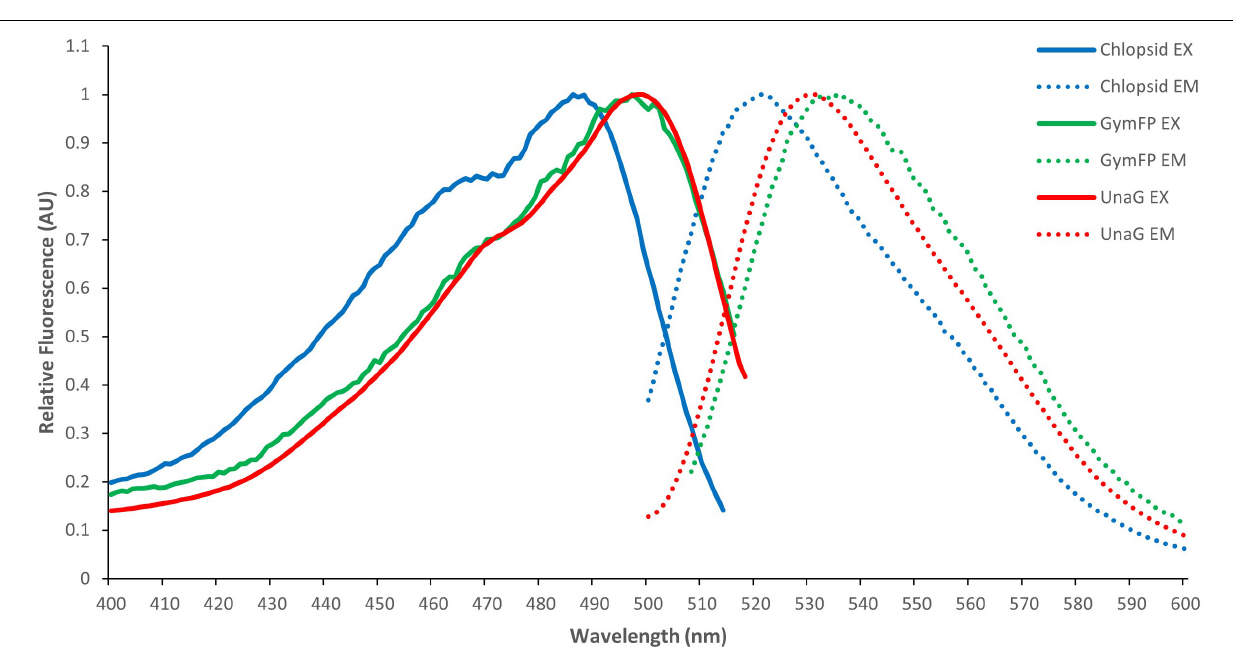
FIGURE 4 | Normalized excitation (EX) and emission (EM) spectra of GymFP (green) compared to Chlopsid FP I (blue) and UnaG